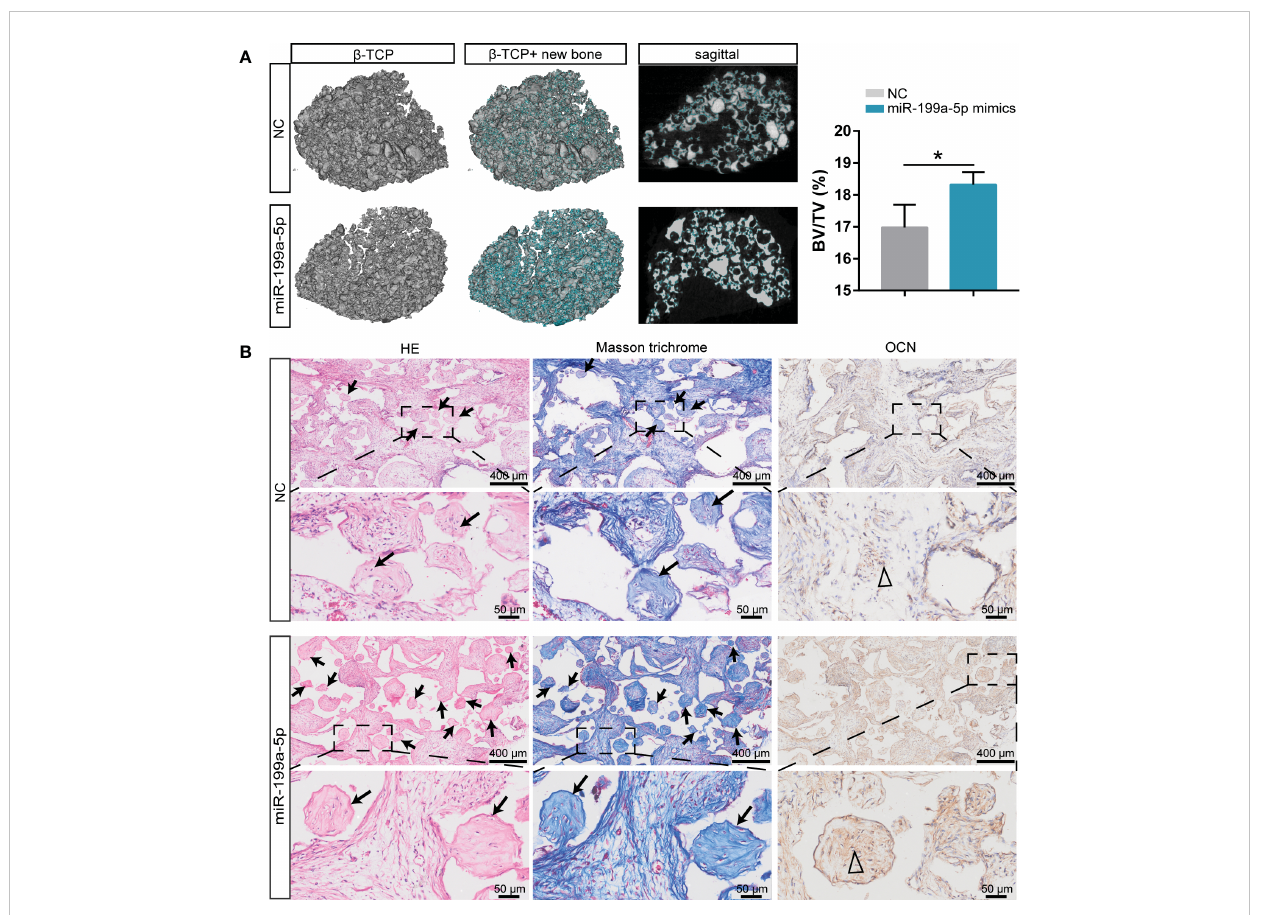
FIGURE 6 Overexpression of miR-199a-5p enhances hSCAPs osteogenic differentiation in vivo . (A) Left: Representative micro-CT images of 3D reconstruction and sagittal pro fi les of bone formation in b -TCP scaffolds of miR-199a-5p mimics (n = 3) and NC groups (n = 3). The blue areas: the region of new bone formation. Right: Quantitative analysis of BV/TV (%). The data were expressed as mean ± SD. * p < 0.05. (B) Representative images of H&E staining, Masson ’ s trichrome staining and immunohistochemical staining of OCN. The black arrows: bone formation. The triangle: positive